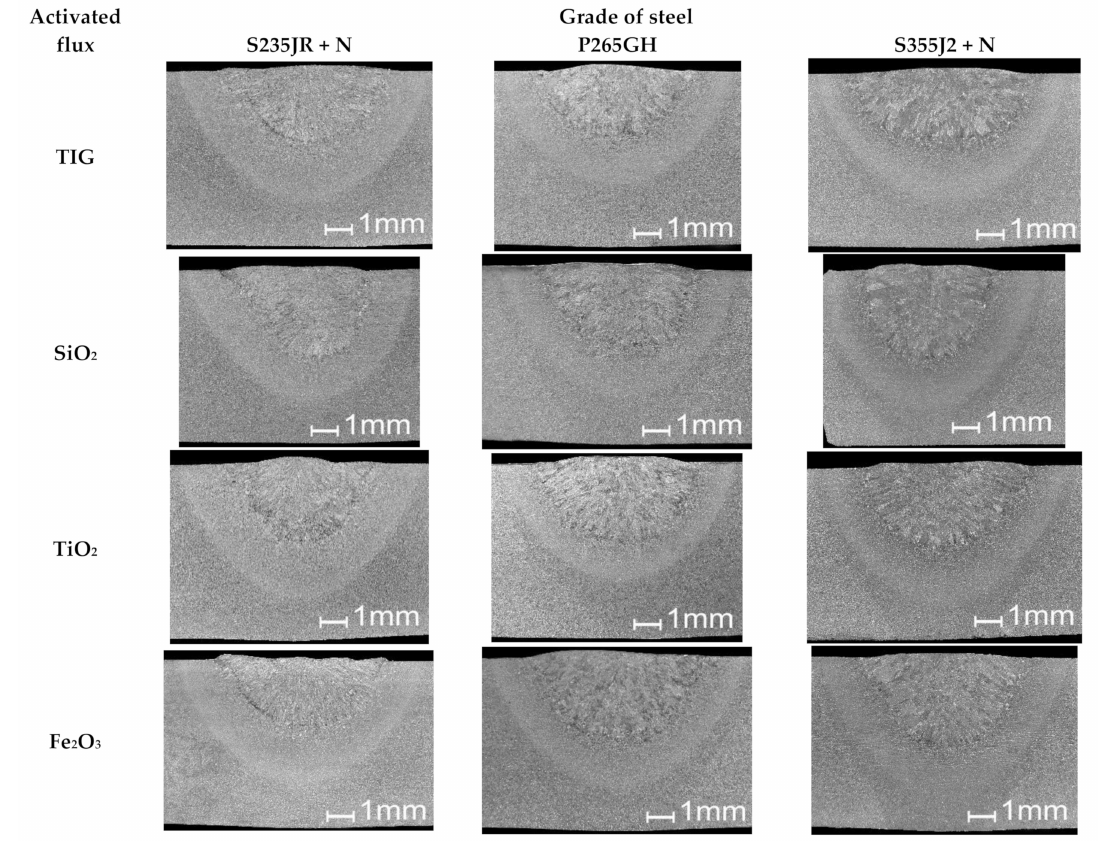
Figure 8. Effect of the activated fluxes on the HAZ dimensions.